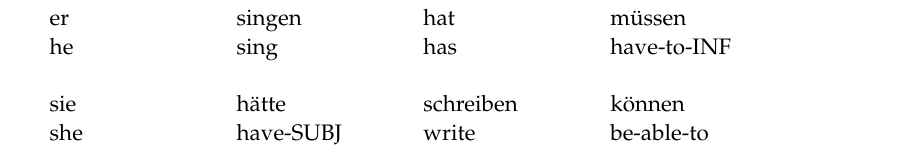
Figure 12. Elementary tree with VR .